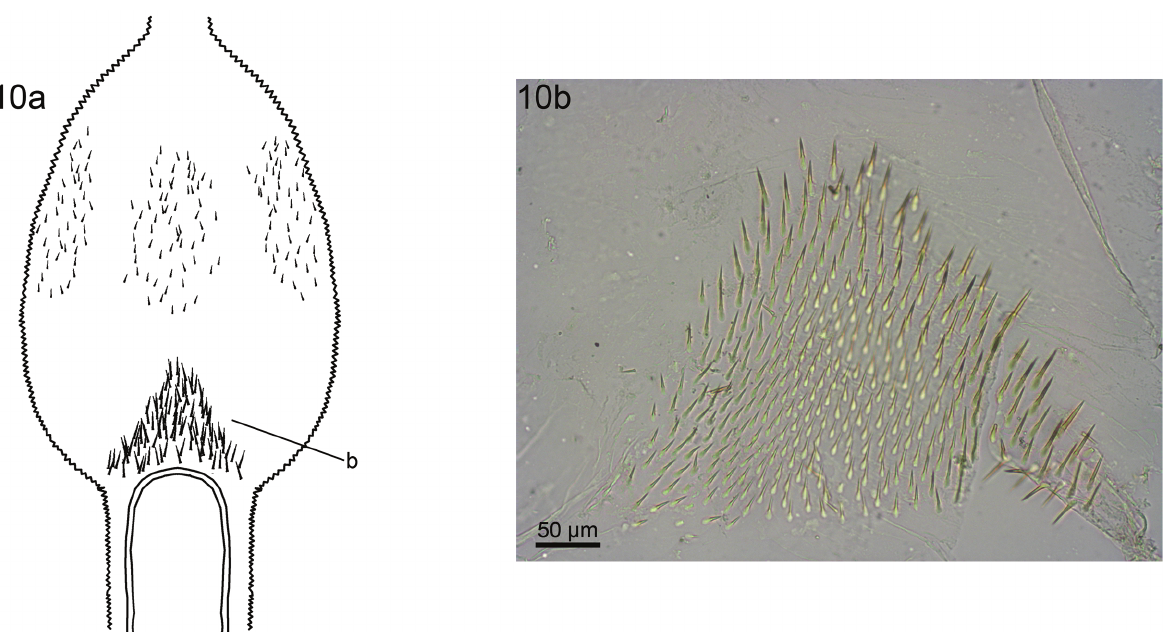
Figure 10. Embiratermes festivellus . (a) Schematic drawing of P1 showing arrangement of spines; (b) Photomicrograph showing detail of aciculiform